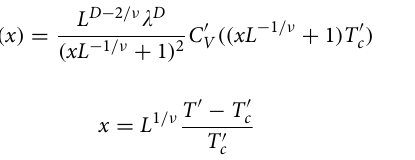
3 2 /ν Figure 6. �( x )/ L − max versus x / L 3 2 /ν 22 σ (cid:31) : L − max from the different system sizes roughly collapse onto the single curve at ν = ′ . �( x )/ L = whereas curves do not overlap in other two